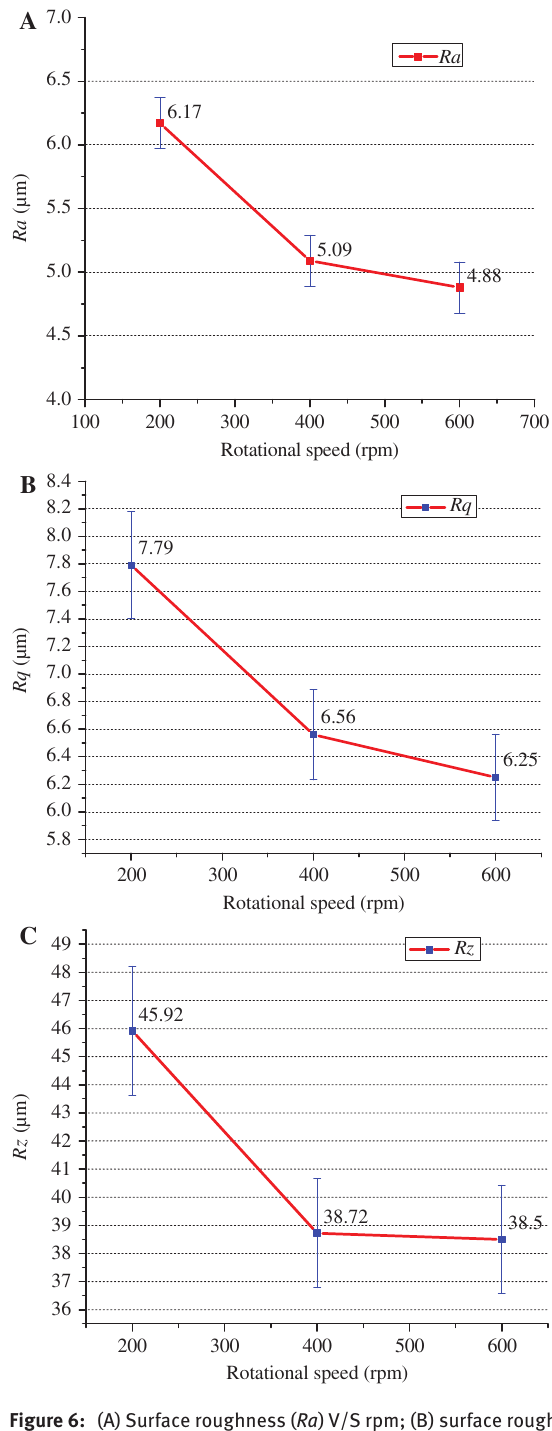
Figure 6: (A) Surface roughness ( Ra ) V/S rpm; (B) surface roughness ( Rq ) V/S rpm; and (C) surface roughness ( Rz ) V/S